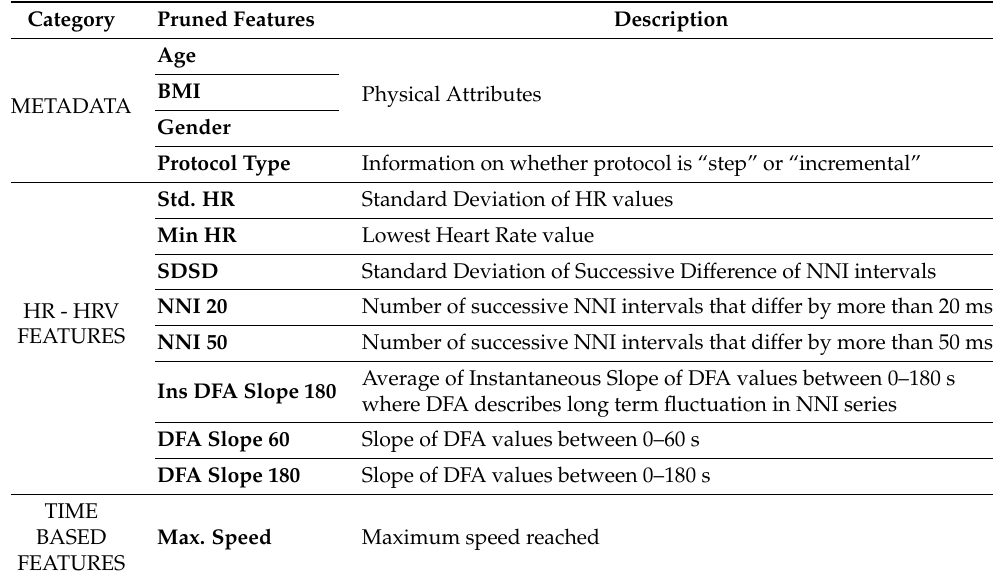
Figure 5. Plots depicting ranking and pruning performed based on mutual information. Each sub plot shows: ( a ) Mutual information between VO 2 max and top 10 ranked features associated with recovery data. ( b ) Undesirable features removed based on Spearman’s correlation coefficient of recovery data. Table 2. Pruned features based on Mutual Information during